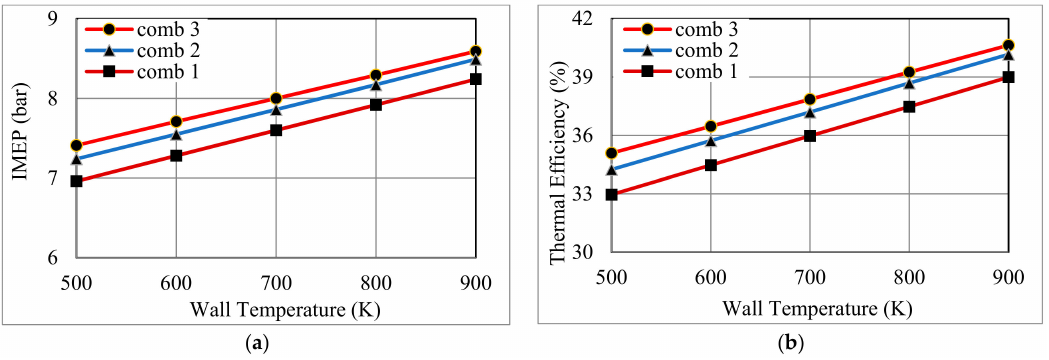
Figure 10. Effects of wall temperature on engine output and efficiency of air cycle simulation with three combustion patterns: ( a ) IMEP ; and ( b ) indicated thermal efficiency.